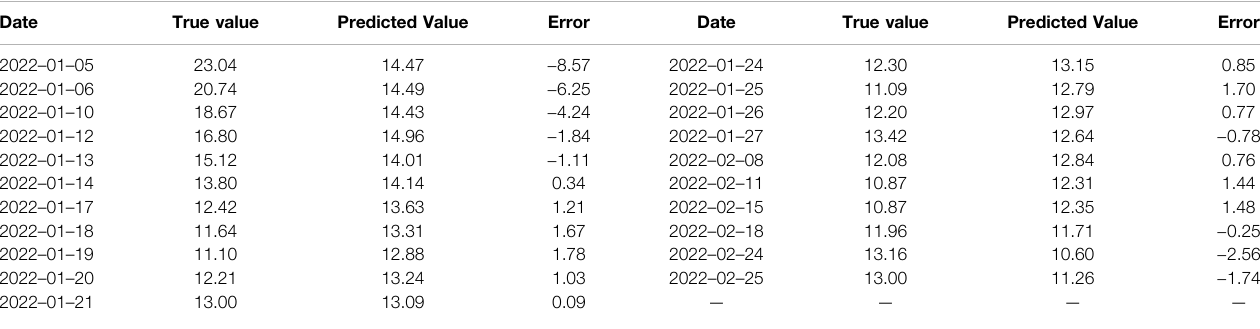
TABLE 2 | Carbon price prediction results in Fujian